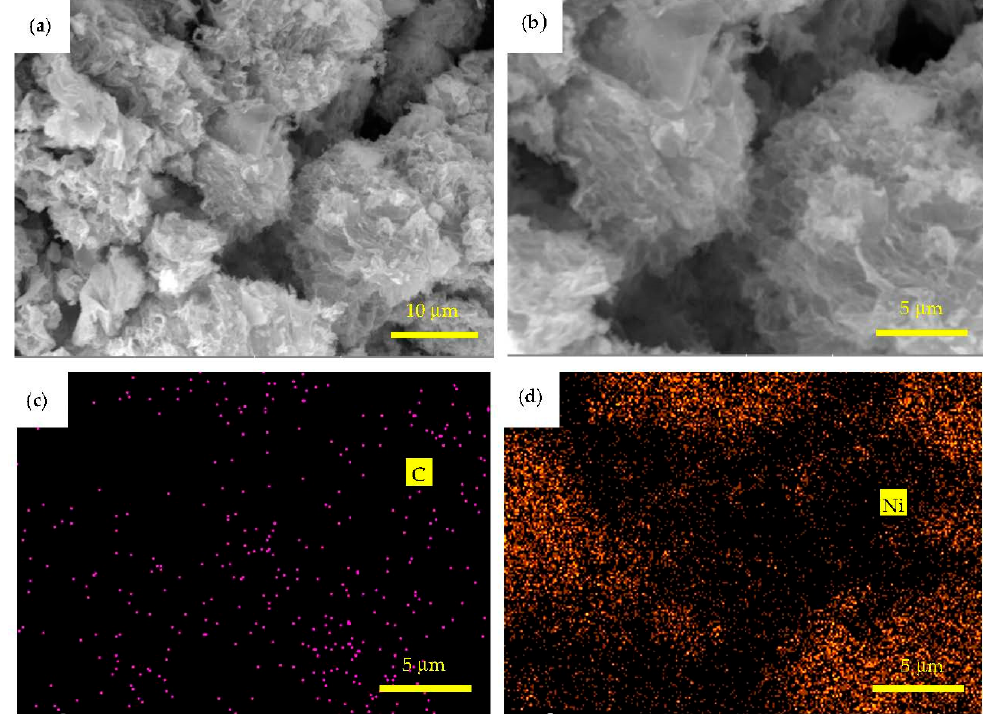
Figure 9. ( a , b ) Backscattered electron image and ( c , d ) energy dispersive X-ray spectrometer C element mapping and Ni element mapping of Ni@graphene.